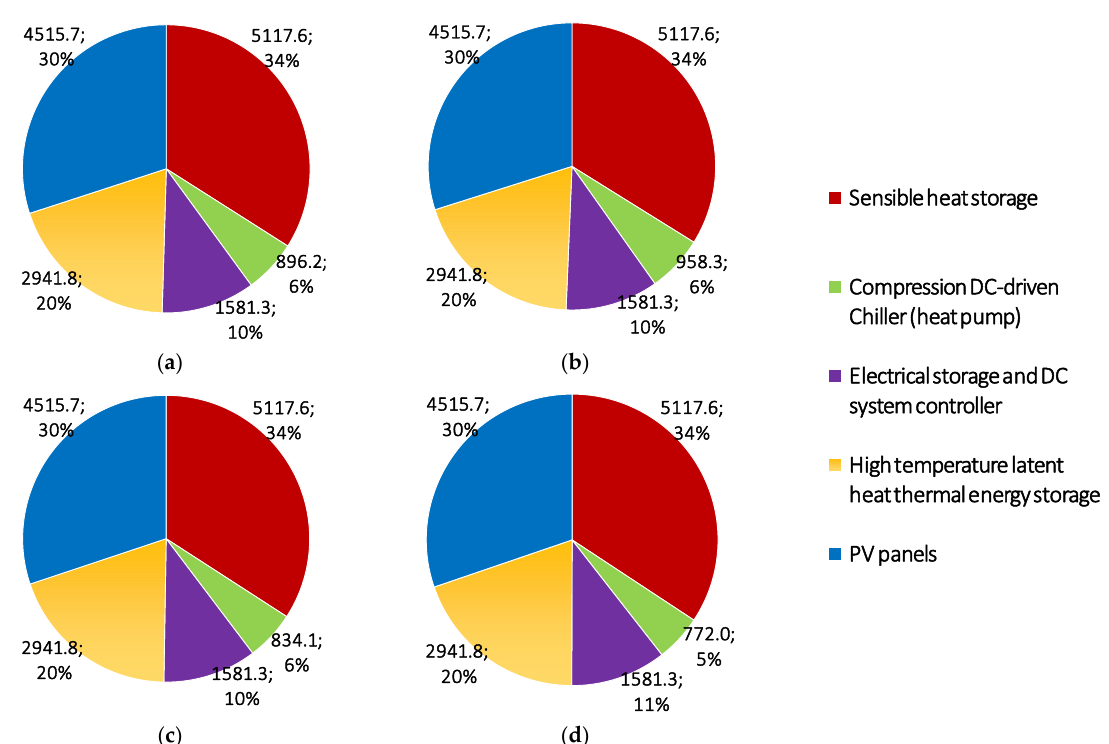
Figure 6. Contribution of the refrigerant to the overall system change in the refrigerant impact: ( a ) R134a (100%); ( b ) 150%; ( c ) 50%; ( d ) 0%.